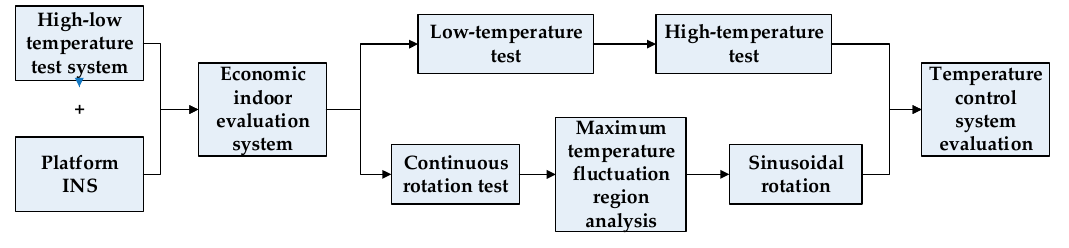
Figure 6. Flowchart of the evaluation method.